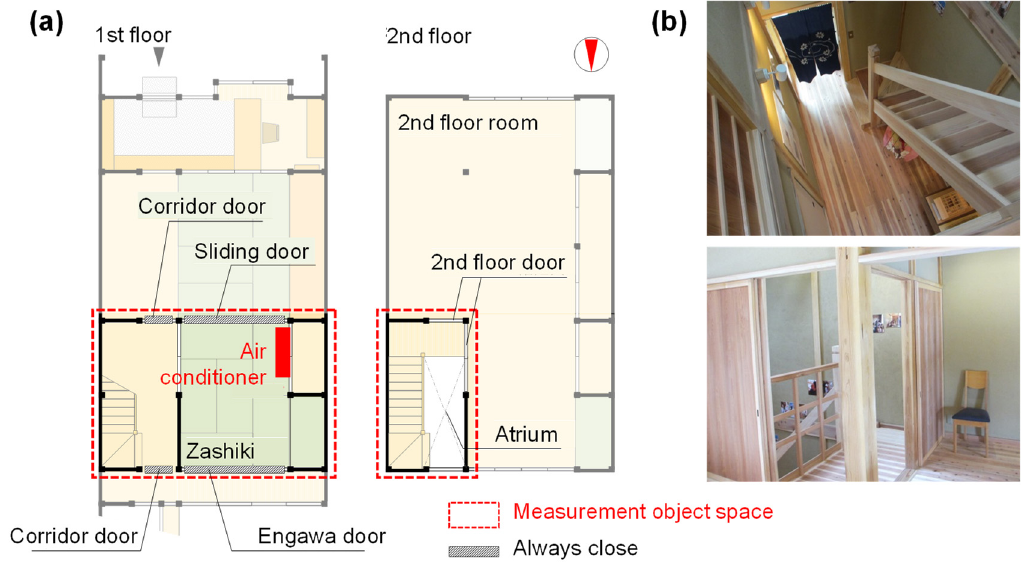
Figure 7. Model residence: ( a ) plan and ( b ) overview of measured staircase.